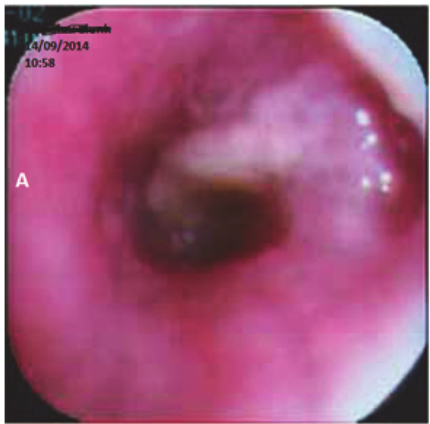
Figure 2: Bronchoscopic examination showed a bulging lesion in the bronchus of the anterior segment of the right upper lobe.